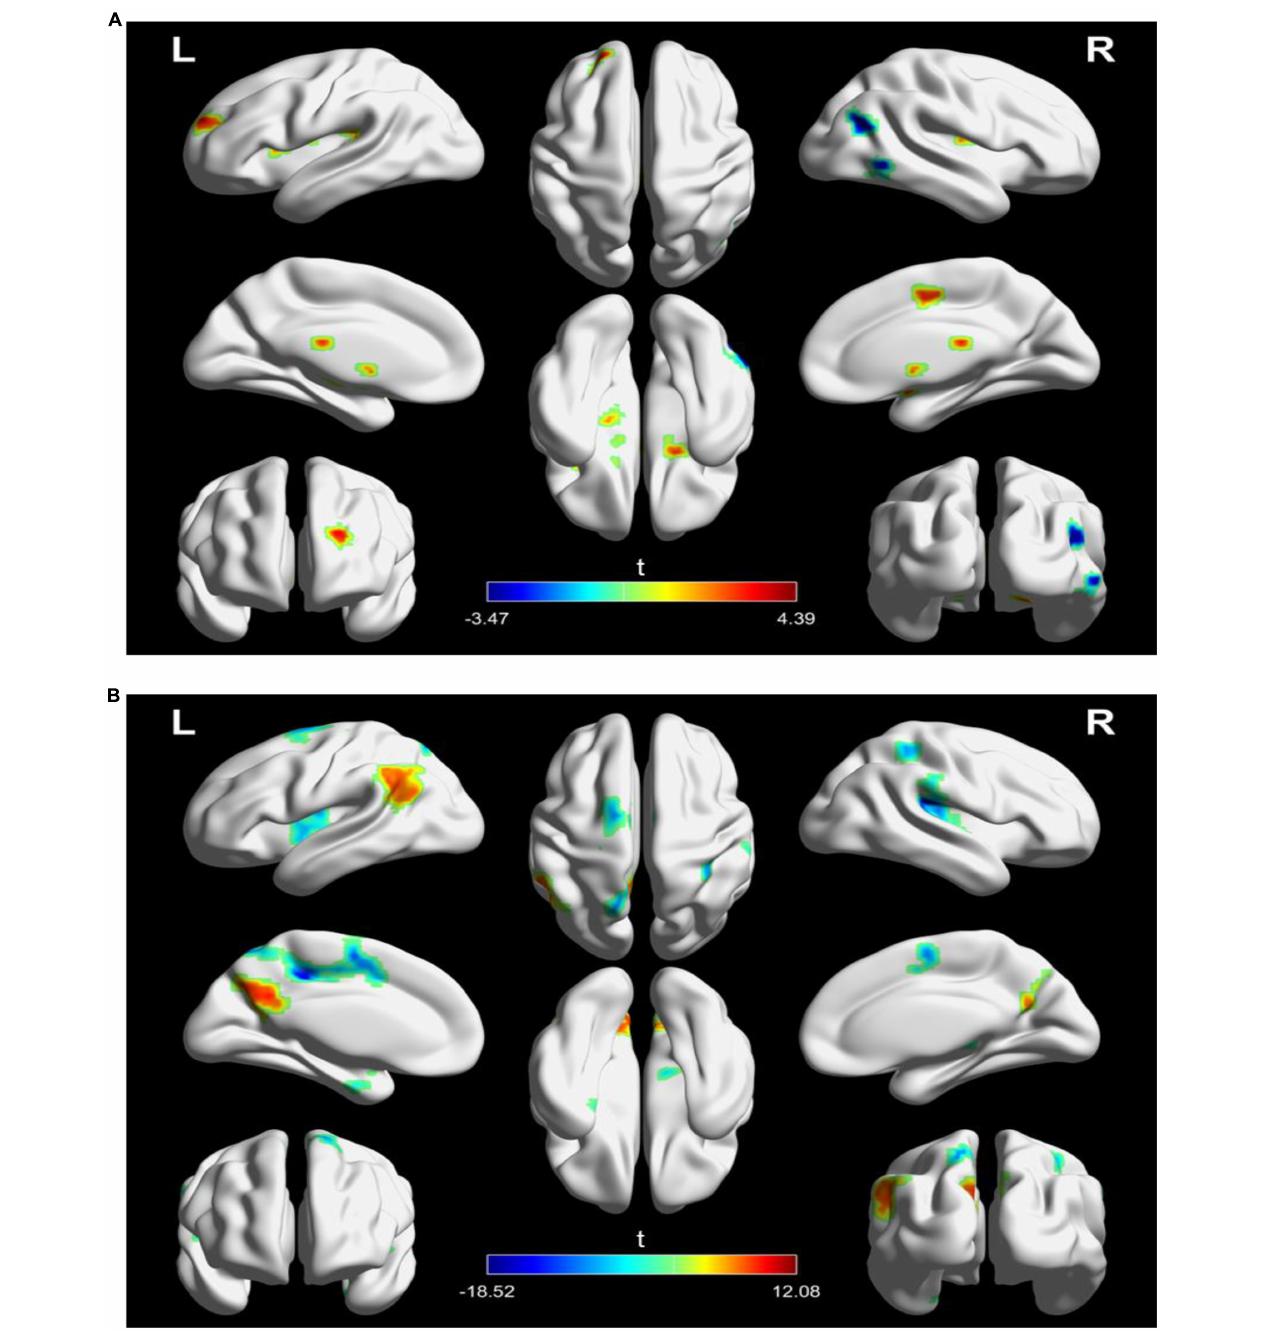
FIGURE3 Significantly changes in static functional connectivity (SFC) of the left TPJ seed between before and after treatment in the two groups. (A) Significantly changes in SFC of the left TPJ seed in the active treatment group (posttreatment vs. pretreatment). (B) Significantly changes in SFC of the left TPJ seed in the placebo group (posttreatment vs. pretreatment). The warm color represents higher connectivity, and the cool color represents lower connectivity (GRF correction, p < 0.05, size > 30). TPJ, left temporoparietal junction; GRF, Gaussian random